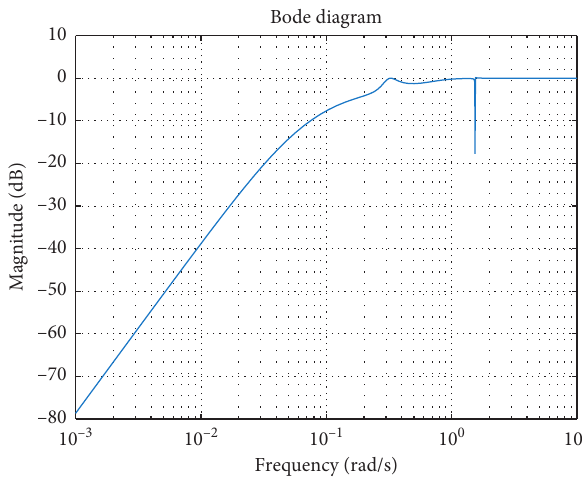
Figure 8: Sensitivity characteristic